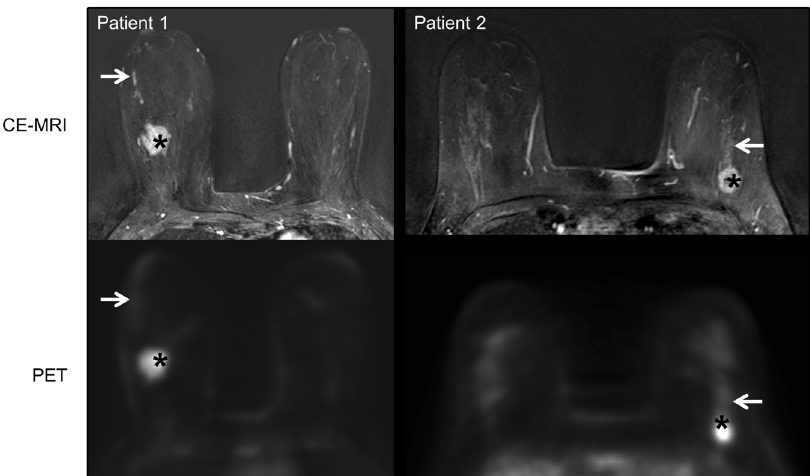
Fig. 8 Representative images from patients. (Patient 1) A 48-year-old with biopsy-proven invasive ductal carcinoma (asterisks) in the right breast with extensive DCIS (arrows), which was proven in fi nal histopathology. Axial subtraction image of contrast-enhanced dynamic breast MRI in the upper half shows the intensively enhancing lesion (asterisk) with a linear non-mass-enhancement (arrow) towards the nipple. In the lower half, axial PET shows the high SUV of the invasive tumor (asterisk; SUV mean 7.39) and low SUV in the localization of DCIS (arrow; SUV max 1.27). (Patient 2) A 46-year-old with biopsy-proven invasive ductal carcinoma (asterisks) in the left breast with associated DCIS (arrows), which was proven in fi nal histopathology. Axial subtraction image of contrast-enhanced dynamic breast MRI in the upper half shows the intensively enhancing lesion (asterisk) with a linear non-mass-enhancement (arrow) towards the nipple. In the lower half, axial PET shows the high SUV of the invasive tumor (asterisk; SUV mean 7.39) and the low SUV in the localization of the DCIS (arrow; SUV max 1.27).